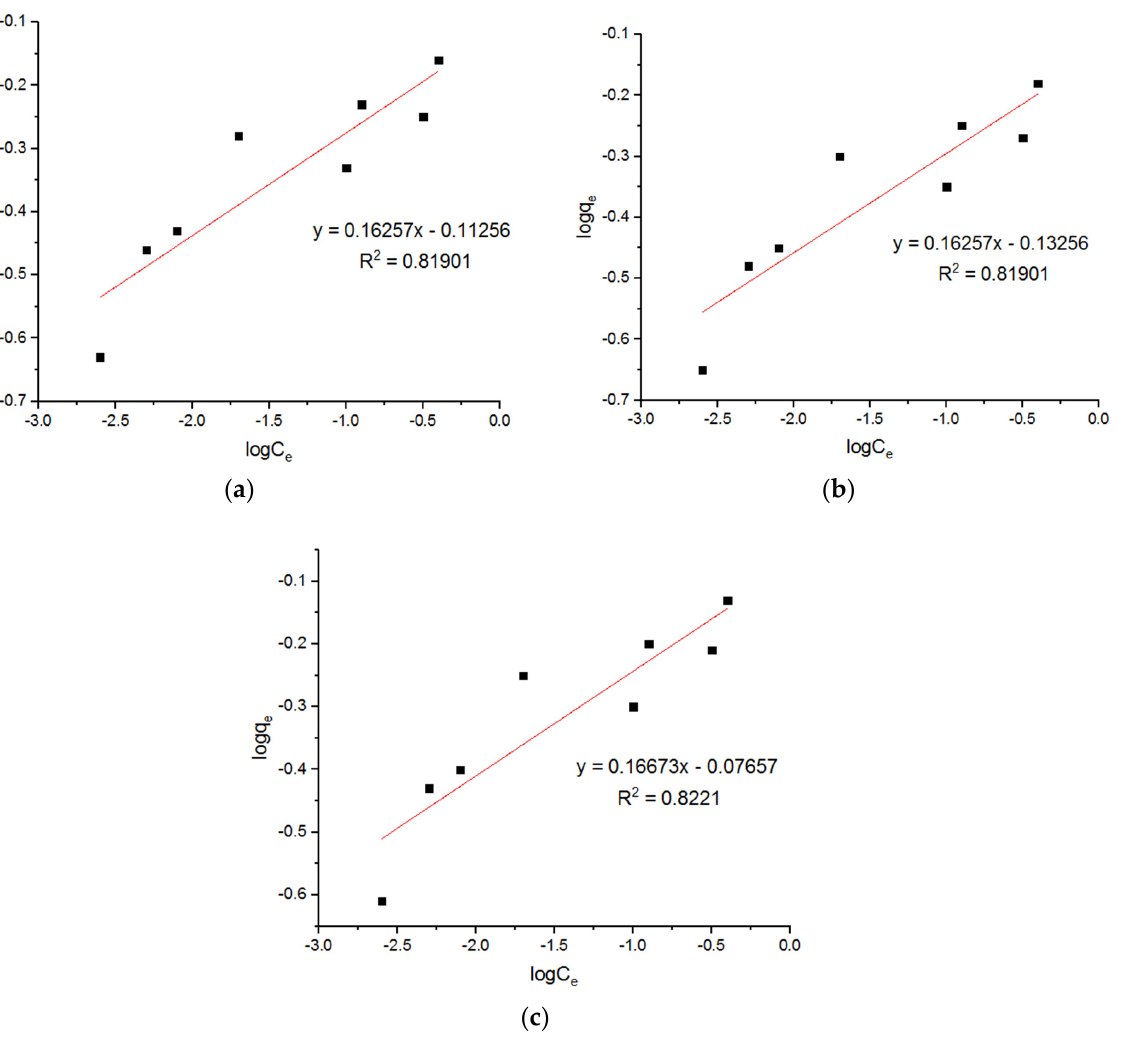
Figure 14. Freundlich plots for adsorption of Cu 2+ onto MgFe 2 O 4 -NH 2 nanoparticles pre-functionalization-calcined at ( a ) 500 °C, ( b ) 600 °C, and ( c ) 700 °C.